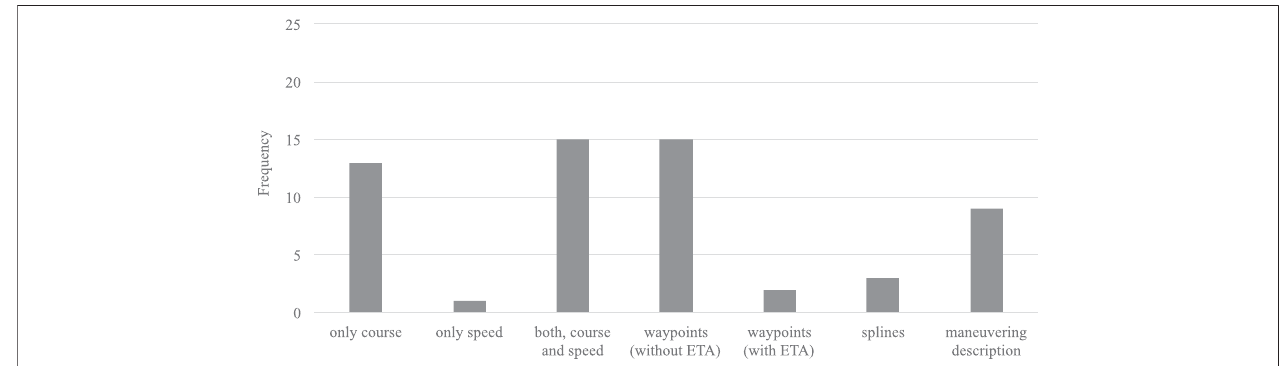
FIGURE 5 | Bar chart of control outputs for the conduct of actions in terms of collision avoidance.